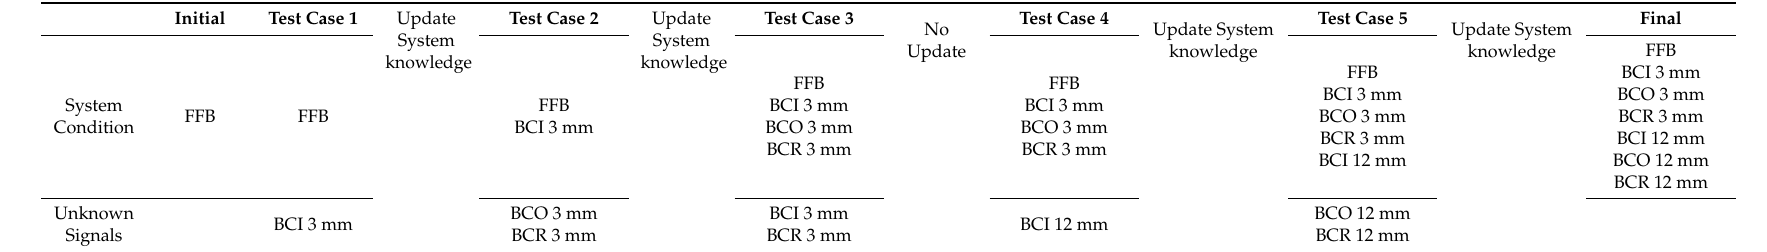
Table 2. Organization of di ff erent test